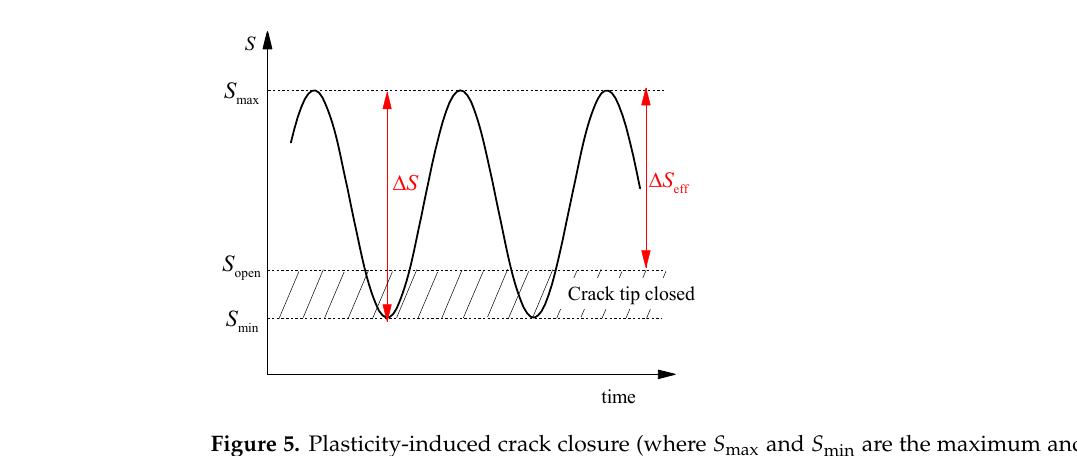
S and S are the maximum and minimum max min